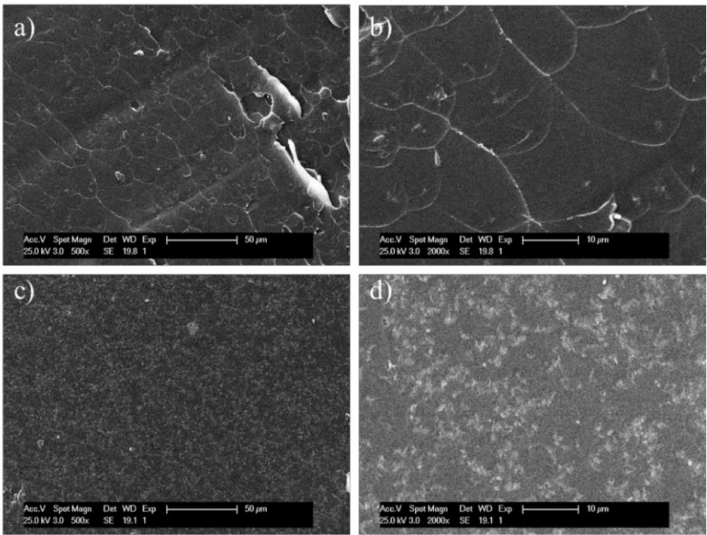
Figure 4. SEM micrographs of PEDOT / epoxy samples with ( a ) and ( b ) 1 wt %, and ( c ) and ( d ) 3 wt